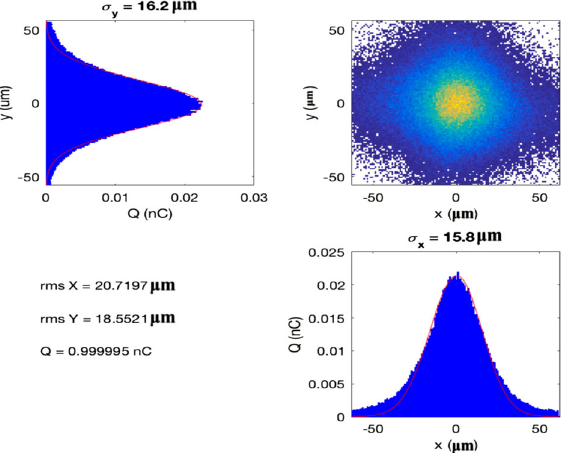
FIG. 7. Transverse projections of the 1-nC positron bunch tracked to sector 20 with 6 kA peak current